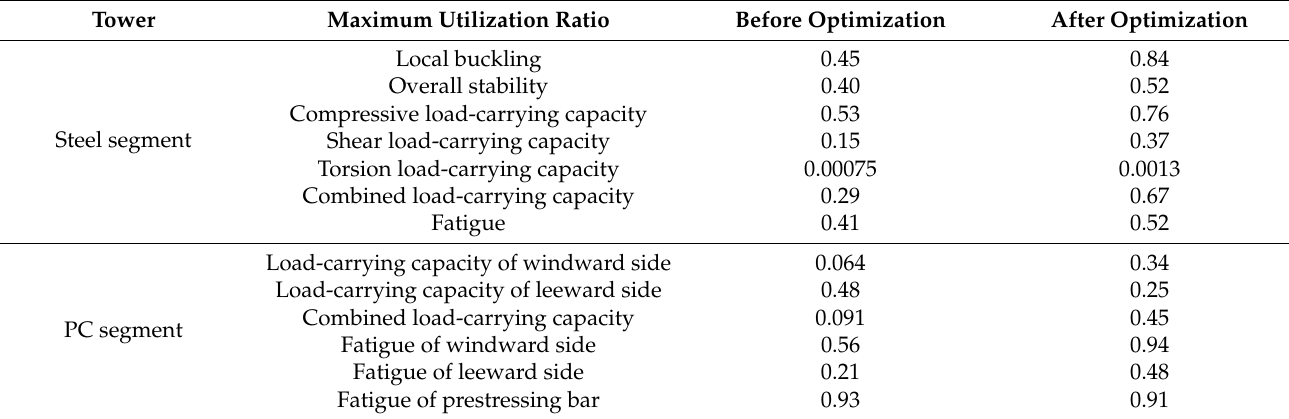
Table 8. The maximum utilization ratio of PCSH tower before and after optimization.